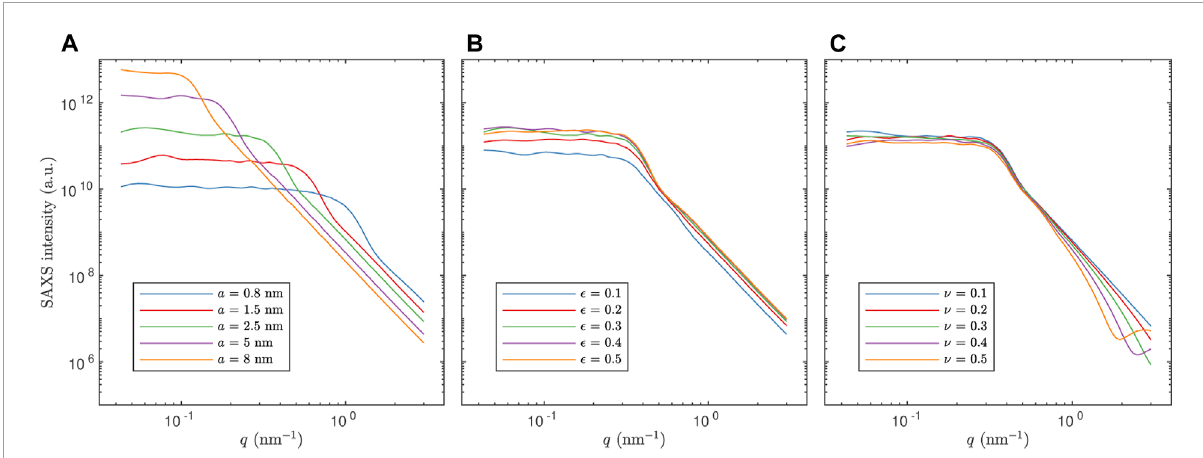
FIGURE 3 Examples of simulated SAXS curves. In (A) , a is varied for ϵ = 0 . 3 and ν = 0 (two-phase model). In (B) , ϵ is varied for a = 2 . 5 nm and ν = 0 (two-phase model). In (C) , ν is varied for a = 2 . 5 nm and ϵ = 0 . 3 (three-phase model). For clarity, measurement noise has not been added to these curves.